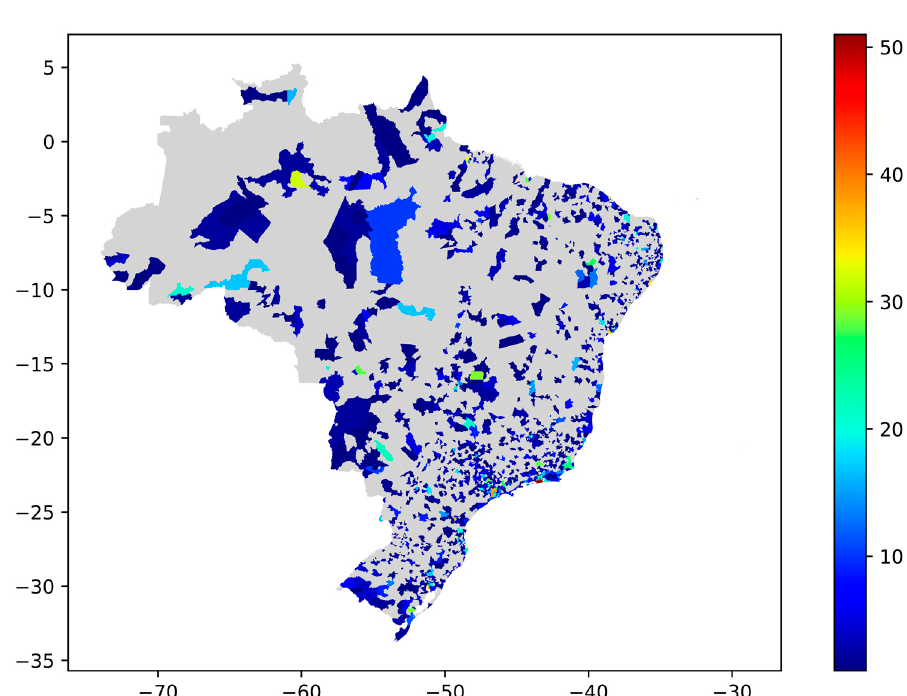
Figure 11. Topic 3 distribution on the Brazilian territory.